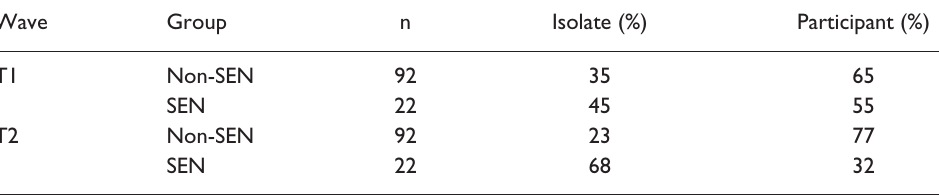
Table 3. Network roles – major